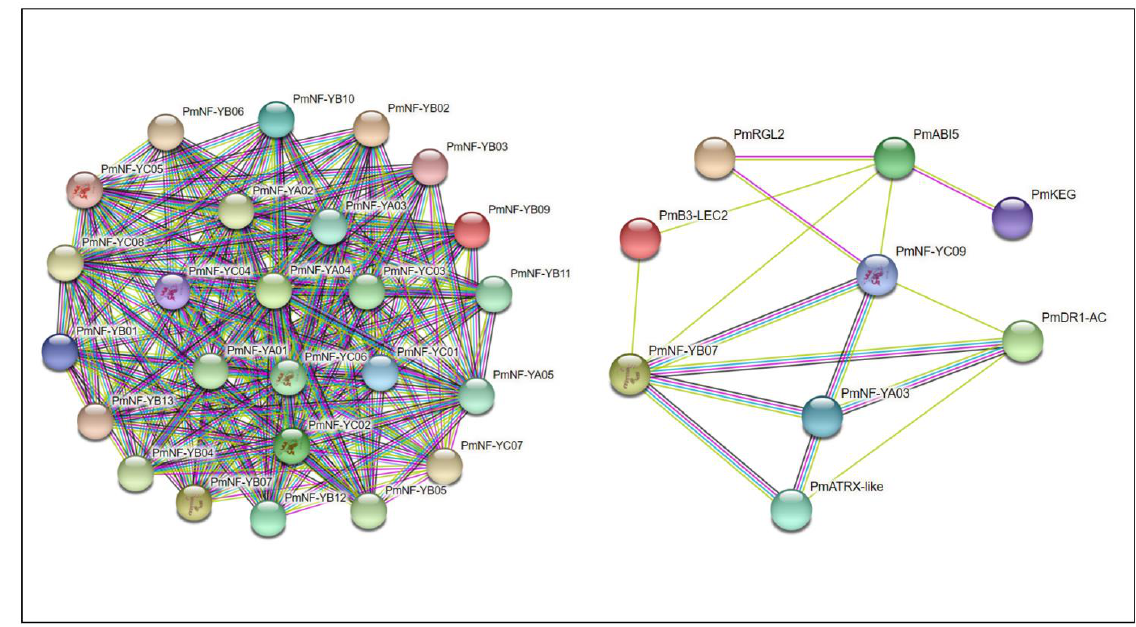
Figure 7. Prediction and analysis of protein – protein interactions of PmNF-Y genes.